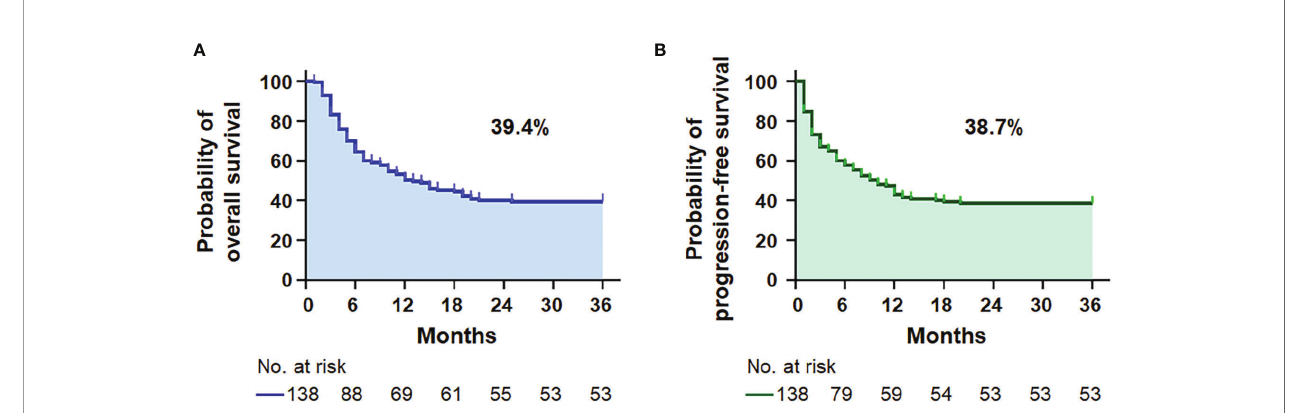
FIGURE 1 | Survival analysis. Kaplan – Meier survival curves for the 3-year overall survival (A) and progression-free survival (B) in 138 patients with AIDS-related lymphoma ( n